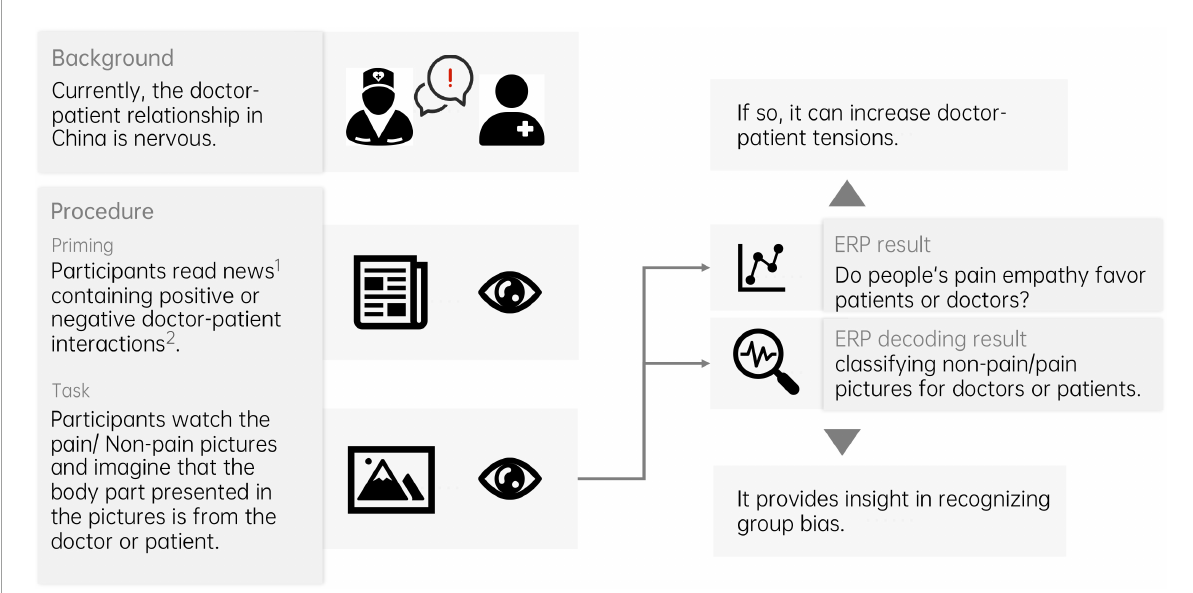
FIGURE1 The research structure. 1 News materials are selected through a rigorous scoring process. 2 The degree of positive or negative doctor–patient interaction is determined by the level of morality exhibited by the patient’s behavior.